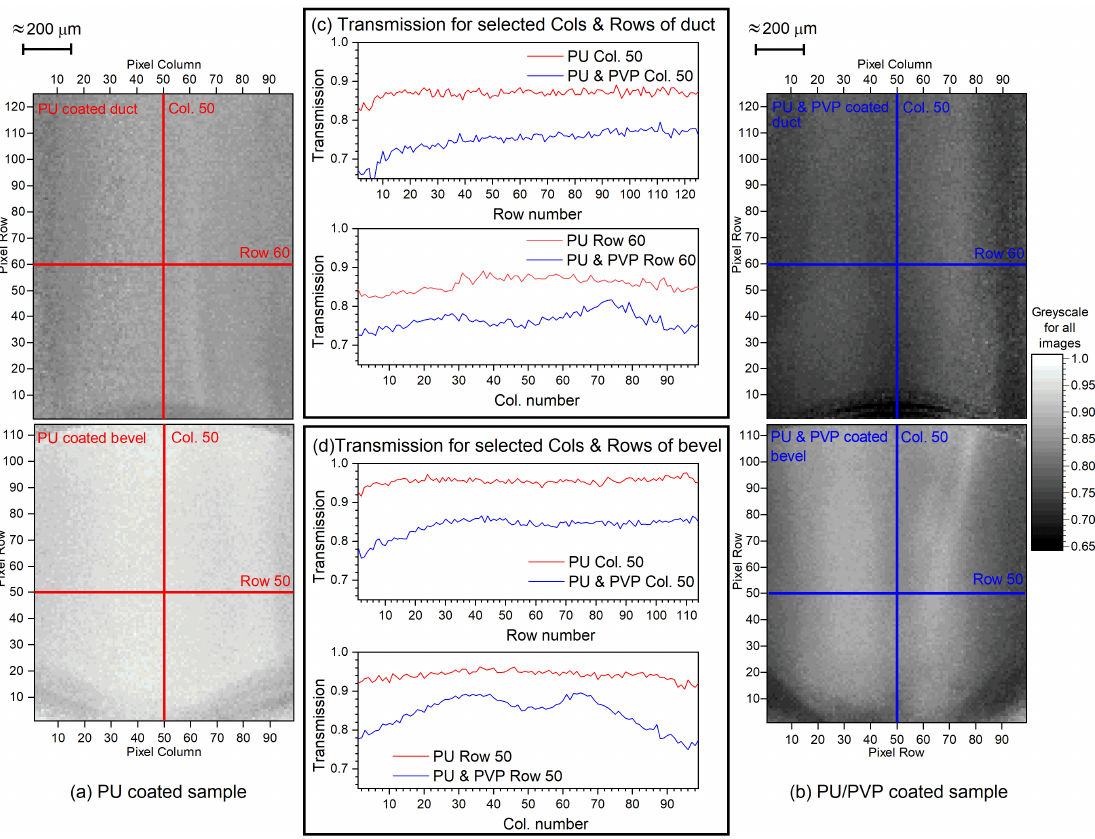
Figure 6. IR transmission greyscale images of PU-coated ( a ) and PU/PVP-coated ( b ) nozzles. Changes in transmission along selected columns and rows, highlighted in the greyscale images of both nozzles, are shown for the duct ( c ) and bevel ( d